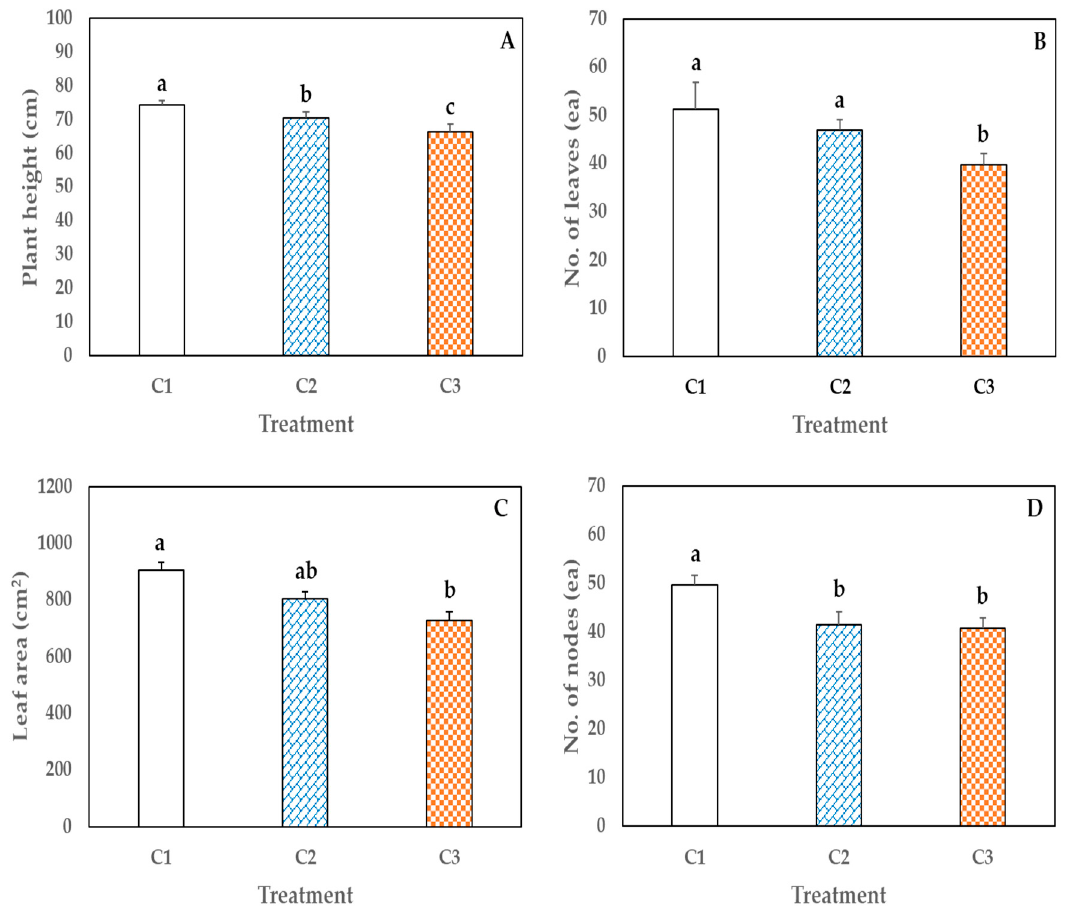
Figure 5. Effect of container size on the growth of M-9 apple rootstock plants at 11 weeks after treat- ment in a greenhouse. C1, C2 and C3 indicate container size 1000 mL, 500 mL and 300 mL, respec- tively.